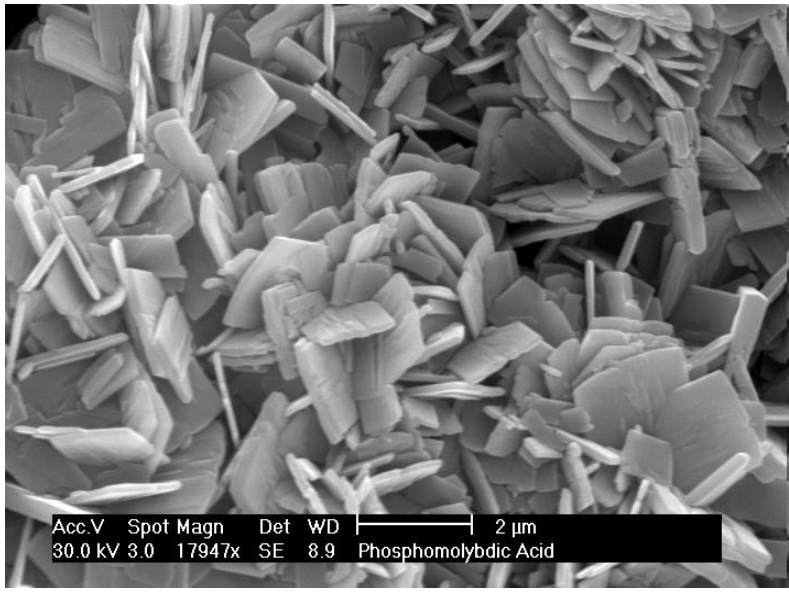
Figure 2. Enviromental Scanning Electron Microscopy (ESEM) of H 3 PMo 12 O 40 . Acc. V: Voltage; Magn: magnification; Det: detector; WD: wide dimension.